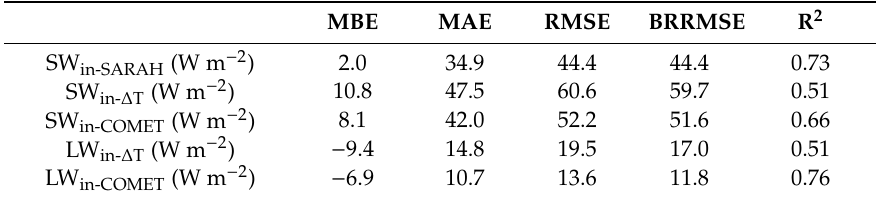
Table 2. Mean bias error (MBE), mean absolute error (MAE), root mean square error (RMSE), bias removed root mean square error (BRRMSE), and common variance (R 2 ) obtained comparing estimated daily shortwave incoming radiation (SW in- ∆ T and SW in-COMET ) and longwave incoming radiation (LW in- ∆ T and LW in-COMET ) values with corresponding values measured at AWS1 Forni (SW in-gl and LW in-gl ). For comparison, we also report the same results presented in Section 2 for the comparison between SW in-gl and SW in-SARAH .